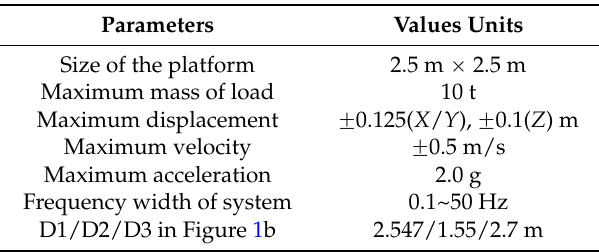
Table 1. Main parameters of dual-shaking table system.